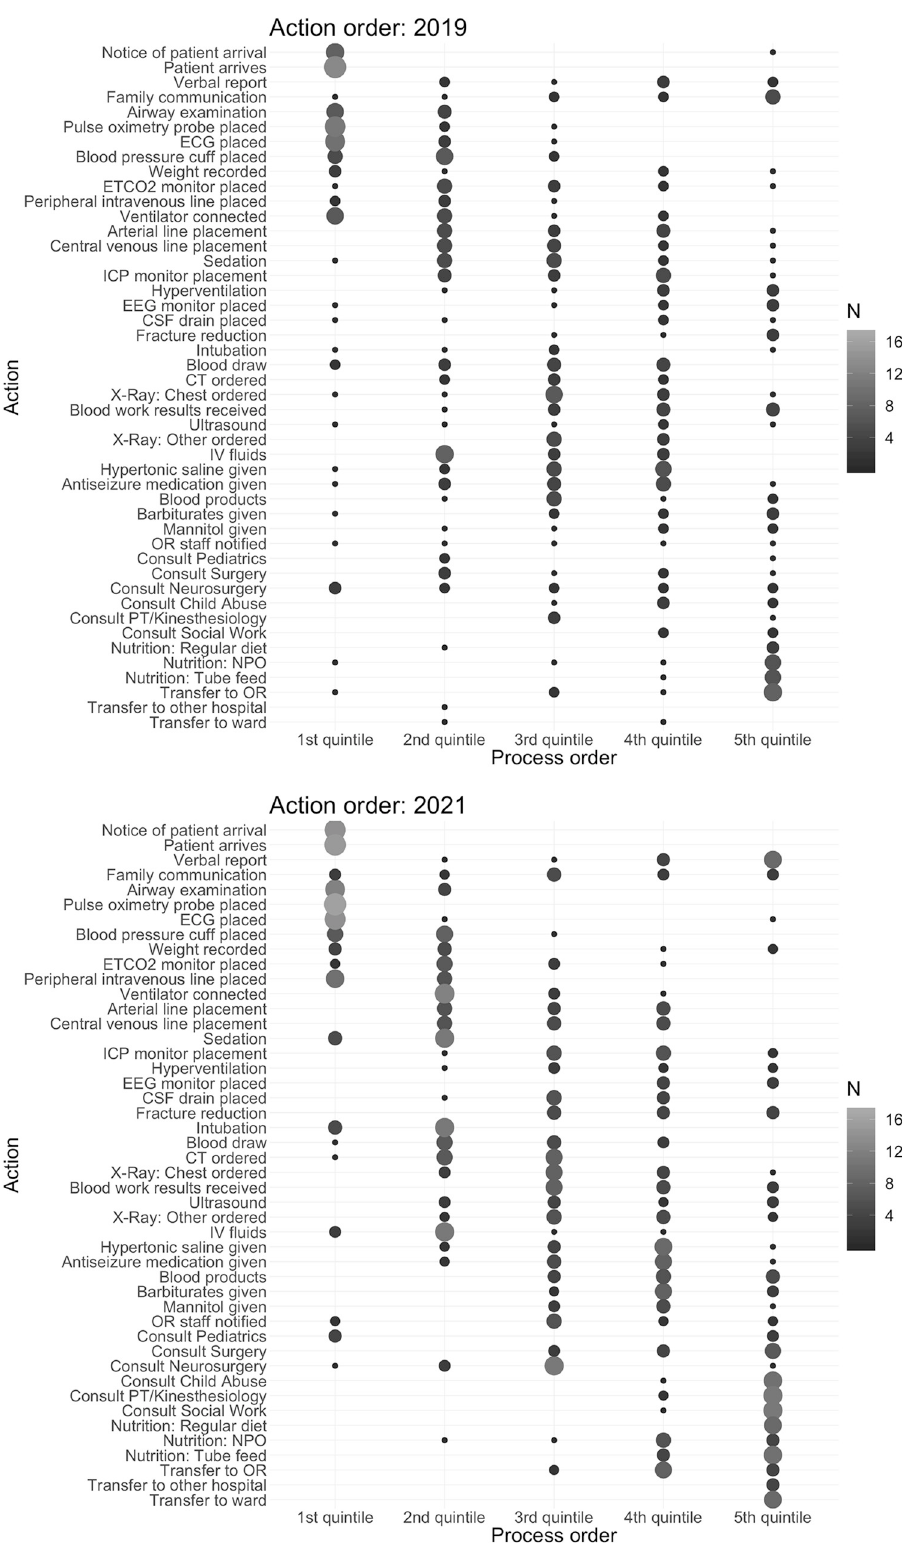
Fig 3. Variability of specific action order in severe pediatric traumatic brain injury care across South American hospitals in 2019 (a) and 2021 (b). X-axis represents earliest to latest actions reported. Larger bubble size and lighter